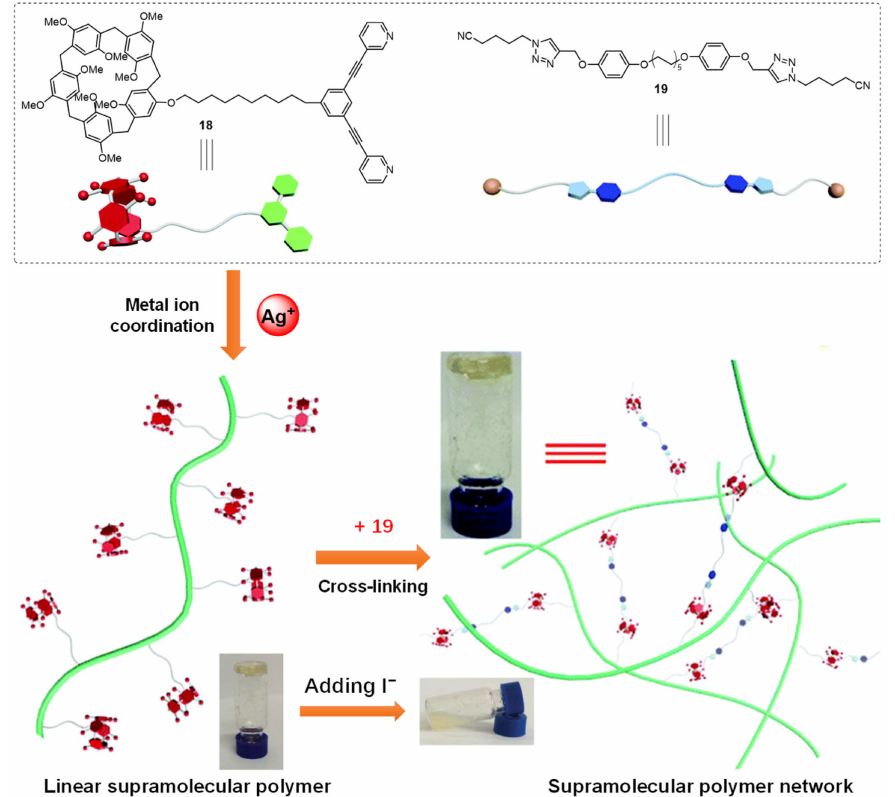
Figure 6. Chemical structures of 18 and 19 and a cartoon representation of the formation of the metallogel. Reprinted with permission from Ref. [43]. Copyright (2017), Royal Society of